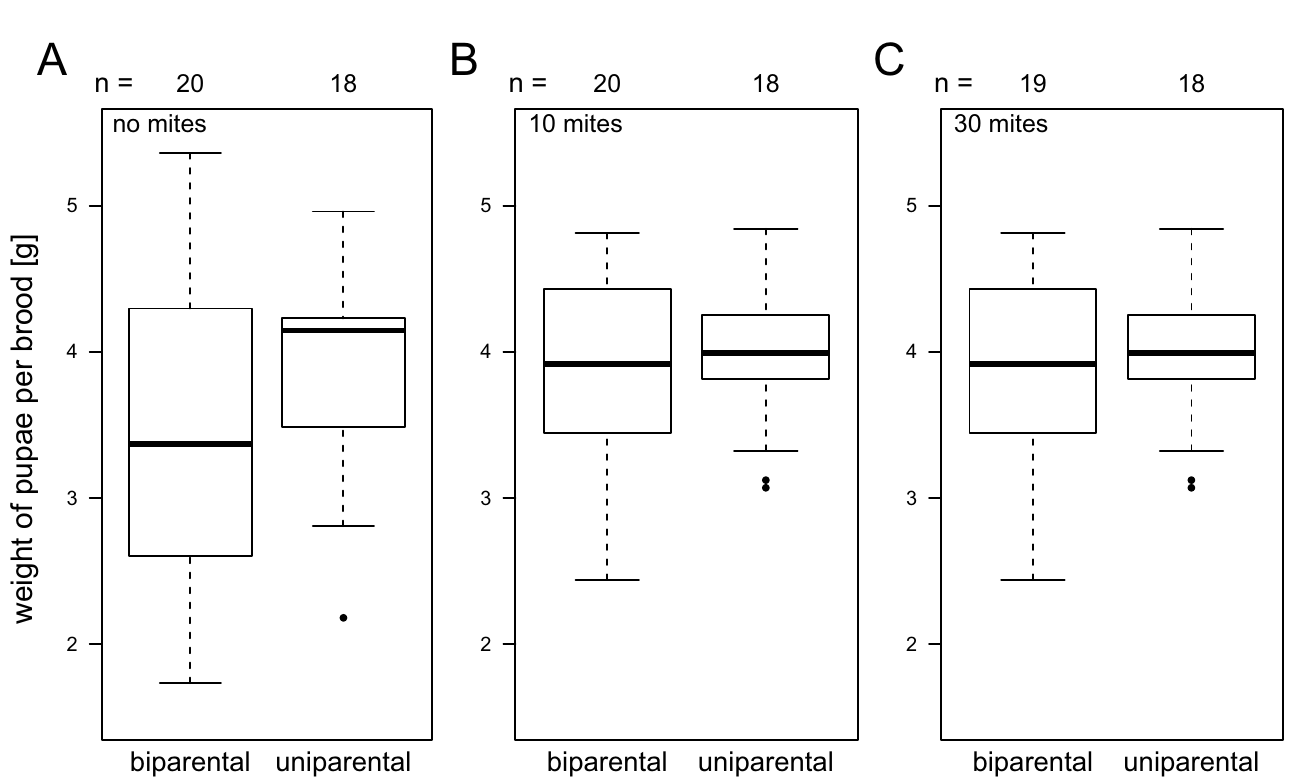
Fig 3. Total beetle brood weight was not affected by the presence of the beetle males (p = 0.09) at any mite dose (interaction p = 0.27). The initial mite dose was 0 (A), 10 (B), or 30 (C) mites, and did not affect beetle brood weight either (p = 0.83). Boxplots depict median (thick line), interquartile range (box), minimum and maximum. Numbers are sample